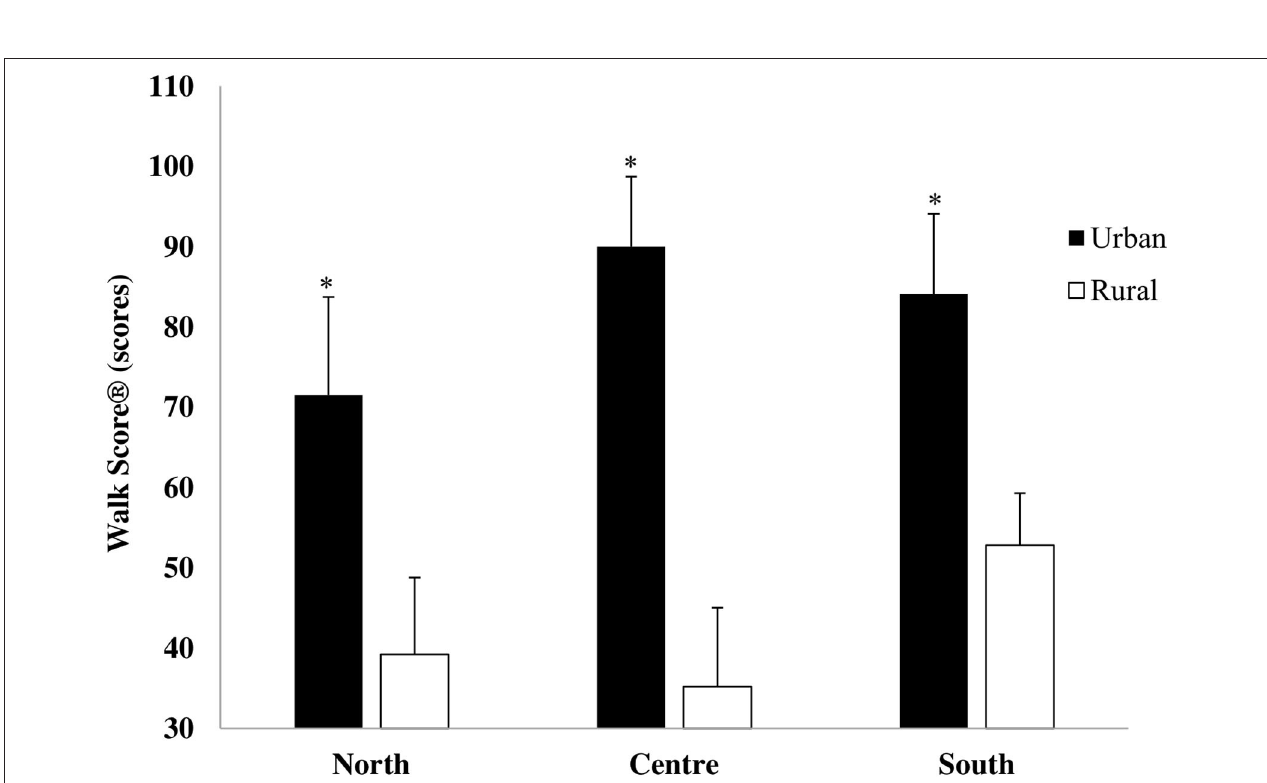
FIGURE 4 | Walk Score ® in urban and rural children of the North, Center, and South of Italy (* p < 0.0001 urban vs. rural).